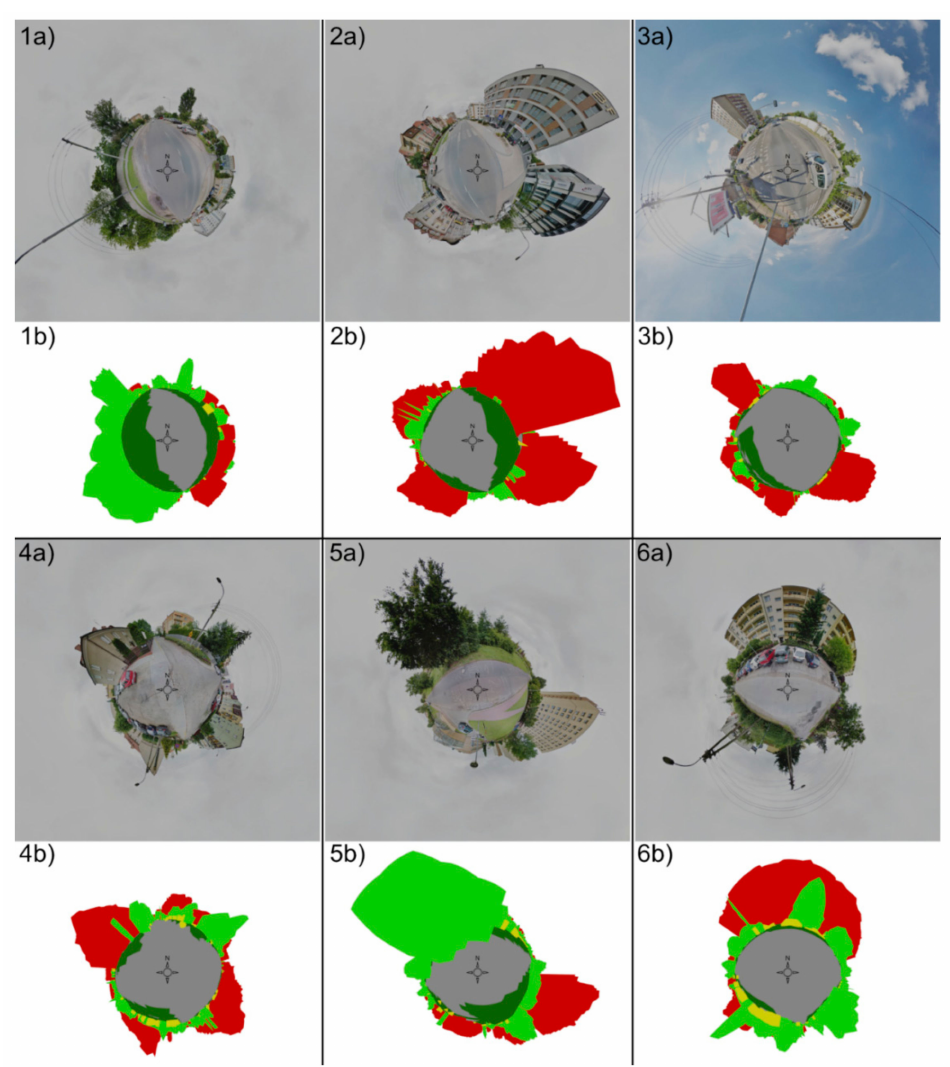
Figure 7. Comparison between stereographic (little planet) projection of GSV ( a ) and rendered images ( b ) for observers